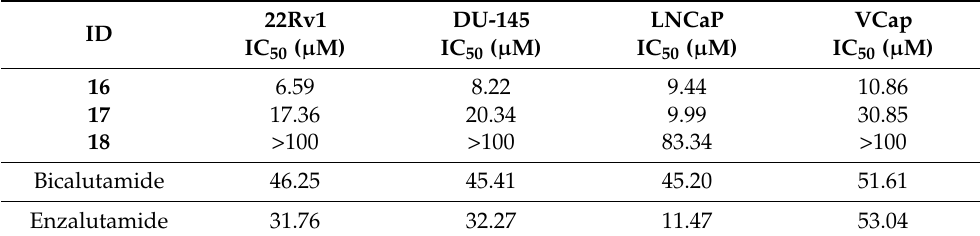
Table 2. In vitro antiproliferative activity of the deshydroxy sulfide analogues of bicalutamide ( 16 – 18 ) across four human prostate cancer cell lines (DU-145, 22Rv, LNCaP, and VCap). All data are mean values from experiments carried out on three separate occasions.